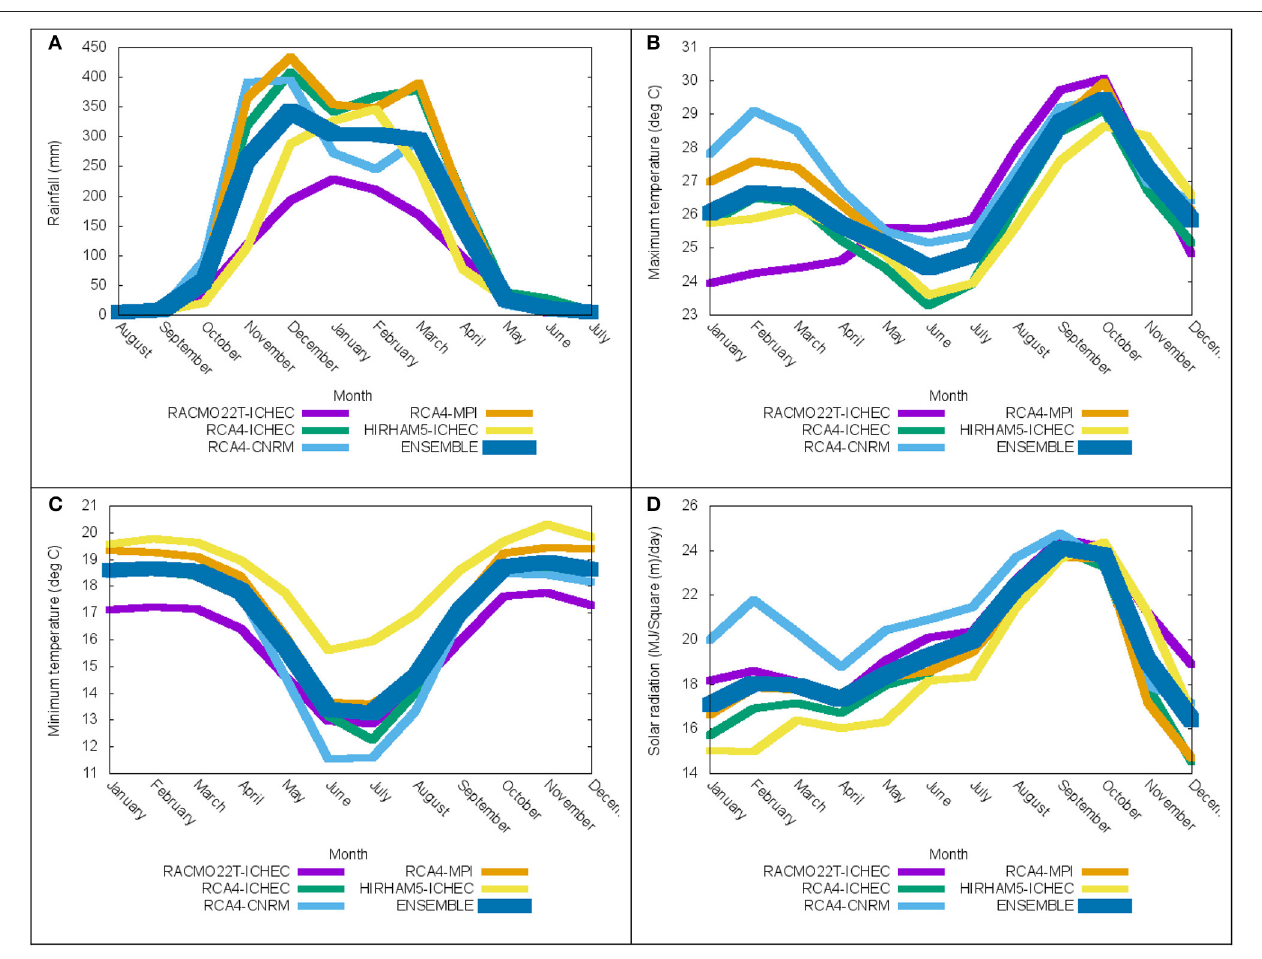
FIGURE 8 | Long-term (2070–2099) annual cycle of climate variables over southern and western highlands sub-agro ecological zones of Tanzania under RCP4.5 (A) rainfall, (B) maximum temperature, (C) minimum temperature, and (D) Solar radiation. TABLE 2 | Soil physical and chemical characteristics over Mbeya region, Tanzania. Soil depth